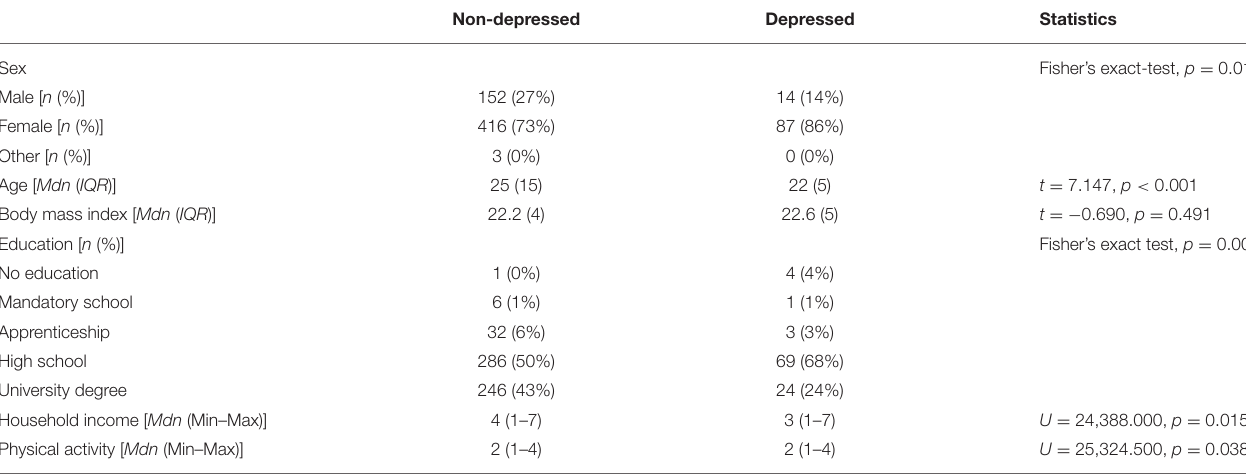
TABLE 1 | Sociodemographic and lifestyle characteristics in depressed ( n = 101) vs. non-depressed ( n = 571) individuals. Non-depressed Depressed Statistics